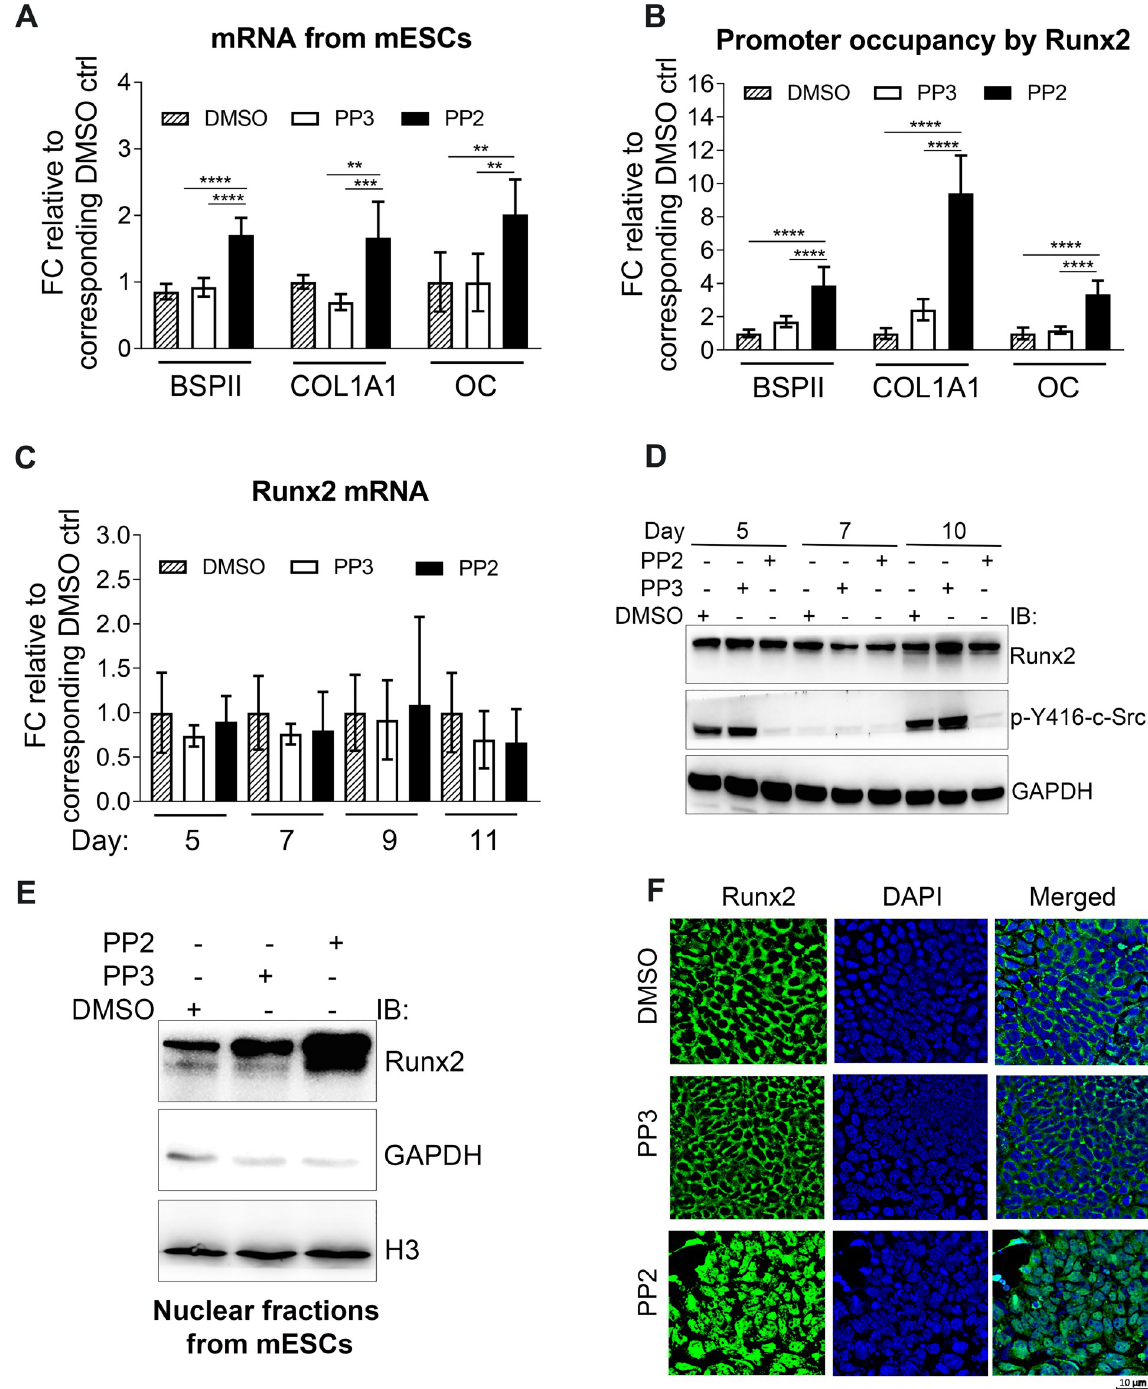
Fig 2. Runx2 nuclear localization and transcriptional activity are increased when c-Src is inhibited in mESCs. (A) Real-time analysis of Runx2 target genes expression including BSPII, COL1A1, and OC in response to c-Src pharmacological inhibition. Day 10 differentiating EBs were treated with either PP2 (10 μ M) or PP3 (10 μ M) and DMSO as controls for 24 hrs. Data are expressed as means ( ± SD) of triplicates. One- way ANOVA is conducted; BSPII: F (2,15) = 42.41, p < 0.0001, COL1A1: F (2,15) = 13.52, p = 0.0004, and OC: F (2,14) = 8.428, p = 0.004. Bonferroni’s multiple comparisons test results for PP2 vs. DMSO and PP2 vs. PP3 treated results are as follows; BSPII: p < 0.0001 for both, COL1A1: p = 0.0098 and p = 0.0004, and OC: p = 0.0087 and p = 0.0084. (B) Promoter occupancy of Runx2 target genes were assessed by ChIP analysis in mESCs. Day 10 differentiating EBs were treated with either PP2 (10 μ M) or PP3 (10 μ M) and DMSO as controls for 24 hrs. Values